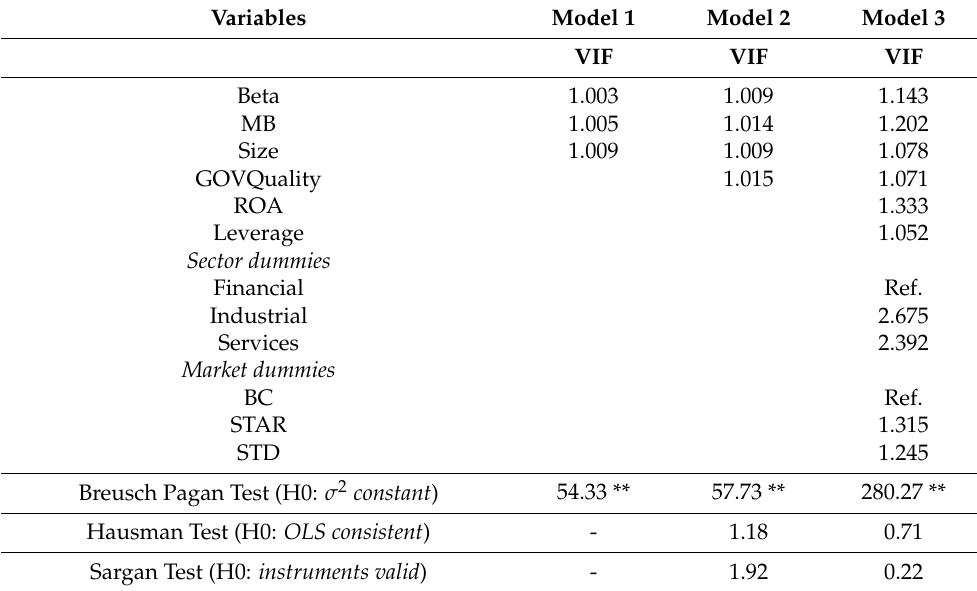
Table 6. Regression analysis